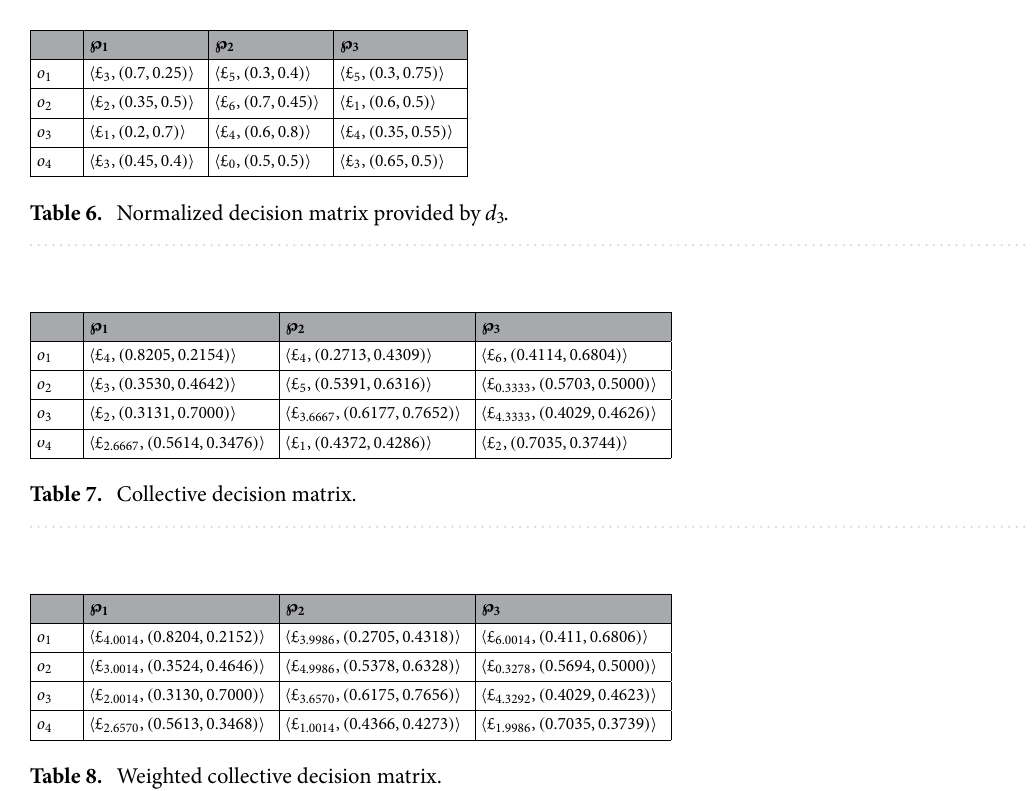
Table 8. Weighted collective decision